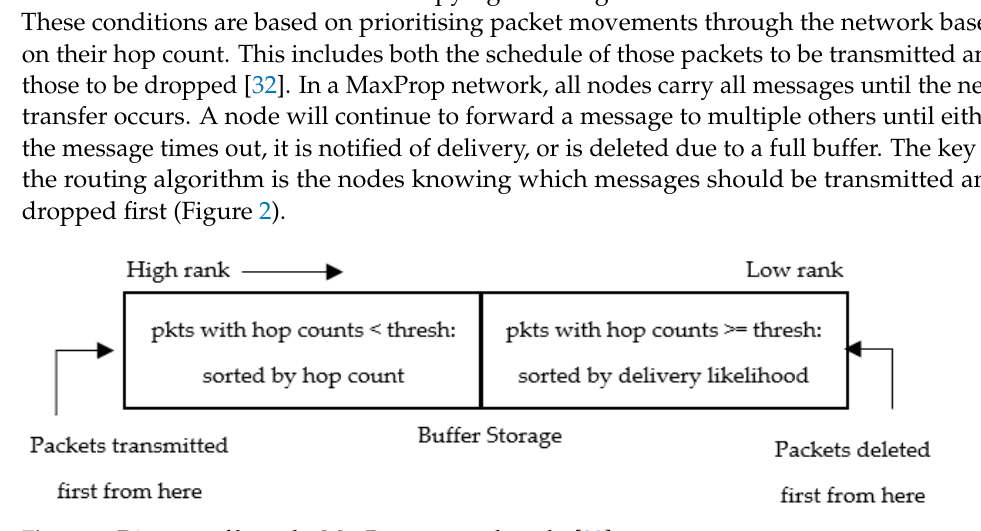
Figure 2. Diagram of how the MaxProp protocol works [32].